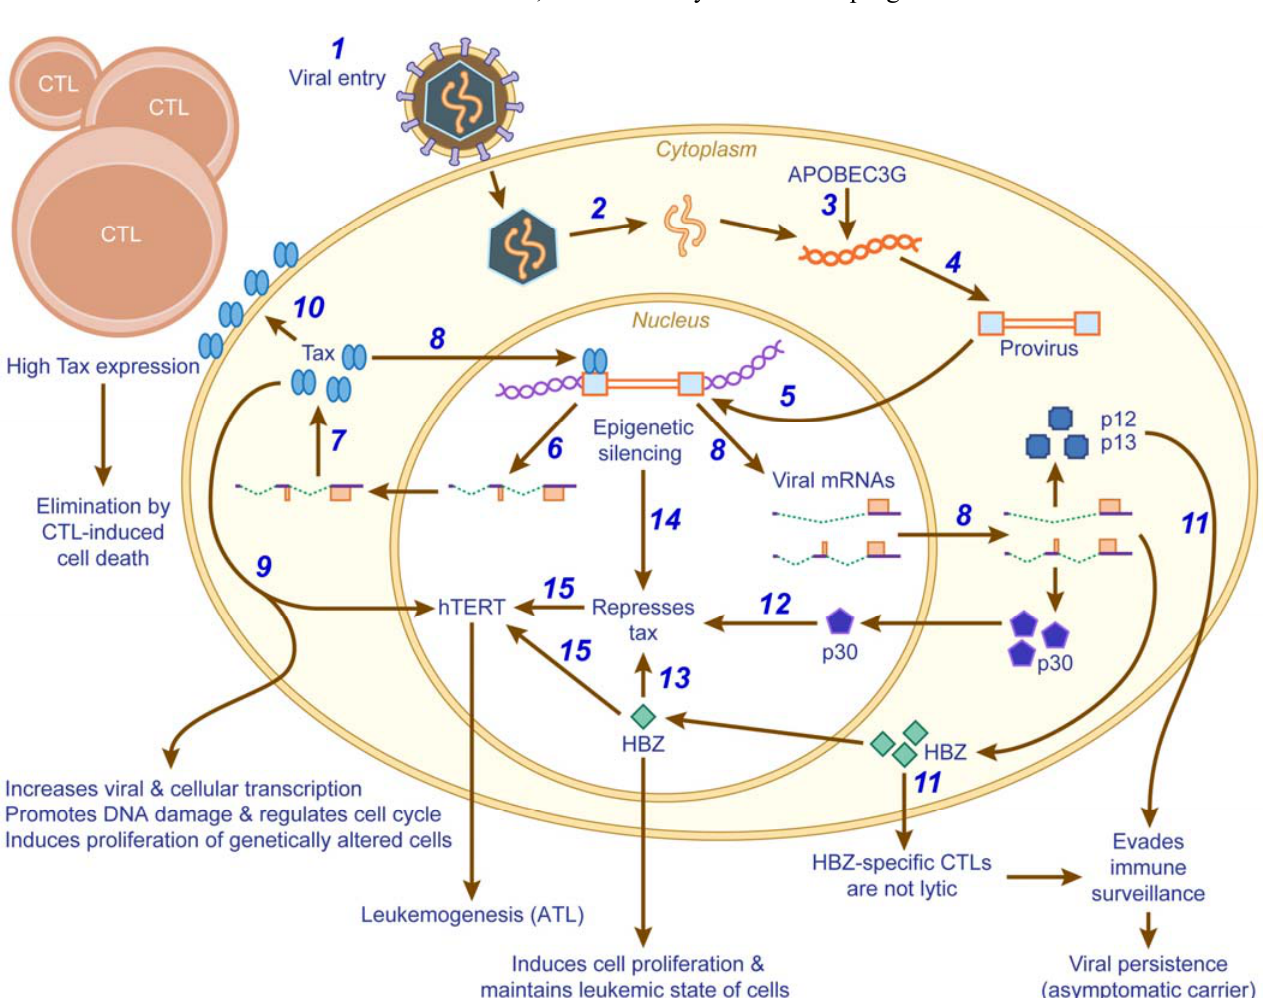
Figure 2. A schematic model illustrating the possible mechanisms by which HTLV-1 succumbs to and evades the host immune system. The sequence of events is labeled with Arabic numerals. 1: attachment